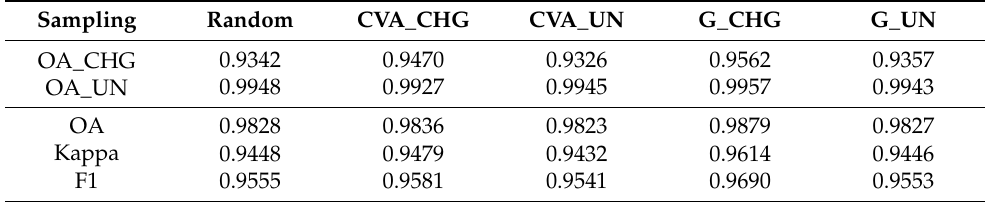
Table 6. Alteration detection results of dataset ‘Taizhou’ using different sampling strategies.